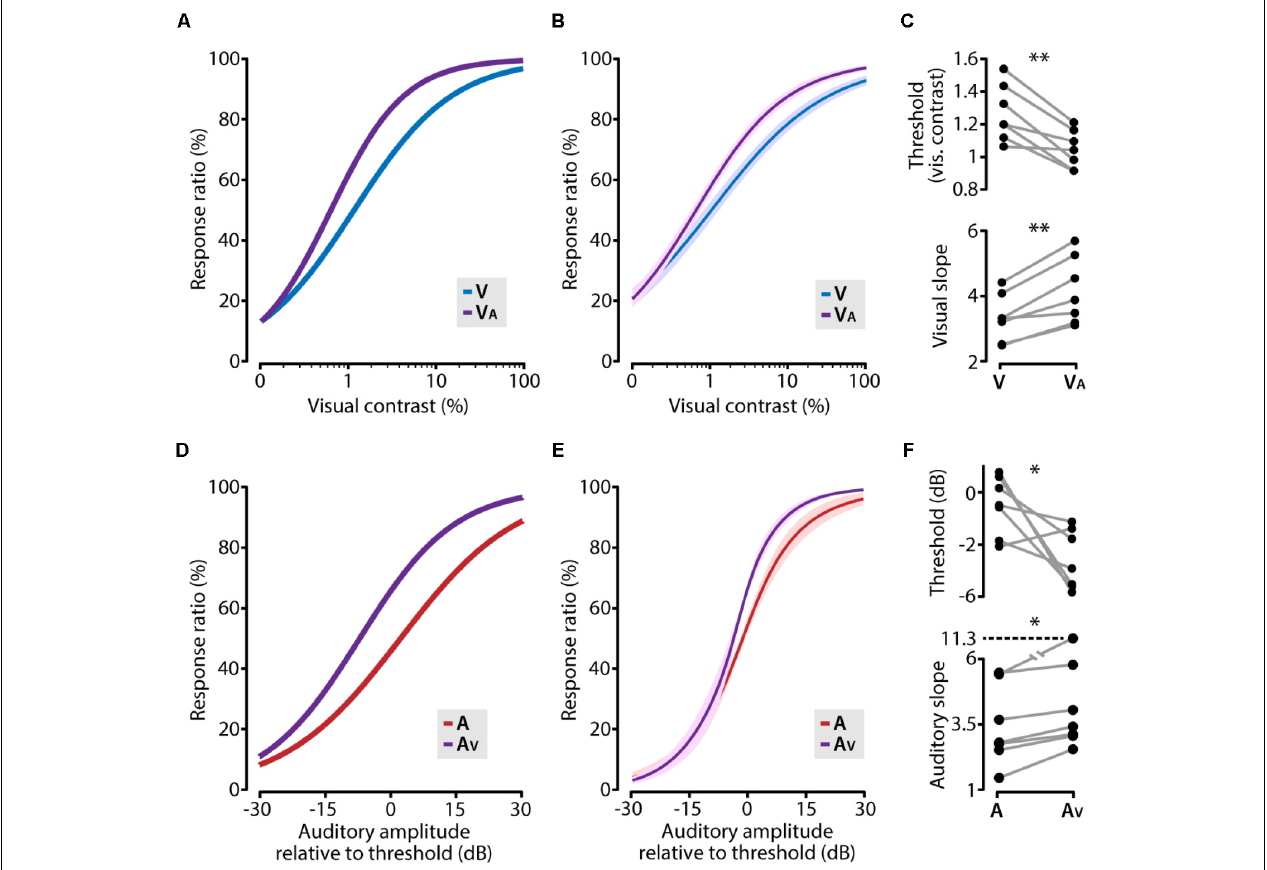
FIGURE 4 | Cross-modal enhancement of perceptual sensitivity. (A) The visual psychometric function (V; blue line) of an example animal shifts toward lower contrasts when the visual stimulus was combined with a subthreshold auditory stimulus (V A ; purple line). (B) The average psychometric function across all animals for visual (V; blue line) and visual supported by subthreshold auditory (V A ; purple line). Solid line indicates the mean, shading SEM. (C) The facilitating role of a subthreshold auditory stimulus resulted in a significant decrease of the visual contrast threshold and a significant steepening of the psychometric function (paired t -test; ∗∗ p < 0.01). (D–F) same as (A–C) but for auditory and auditory supported by sub threshold visual stimuli (paired t -test; ∗ p <